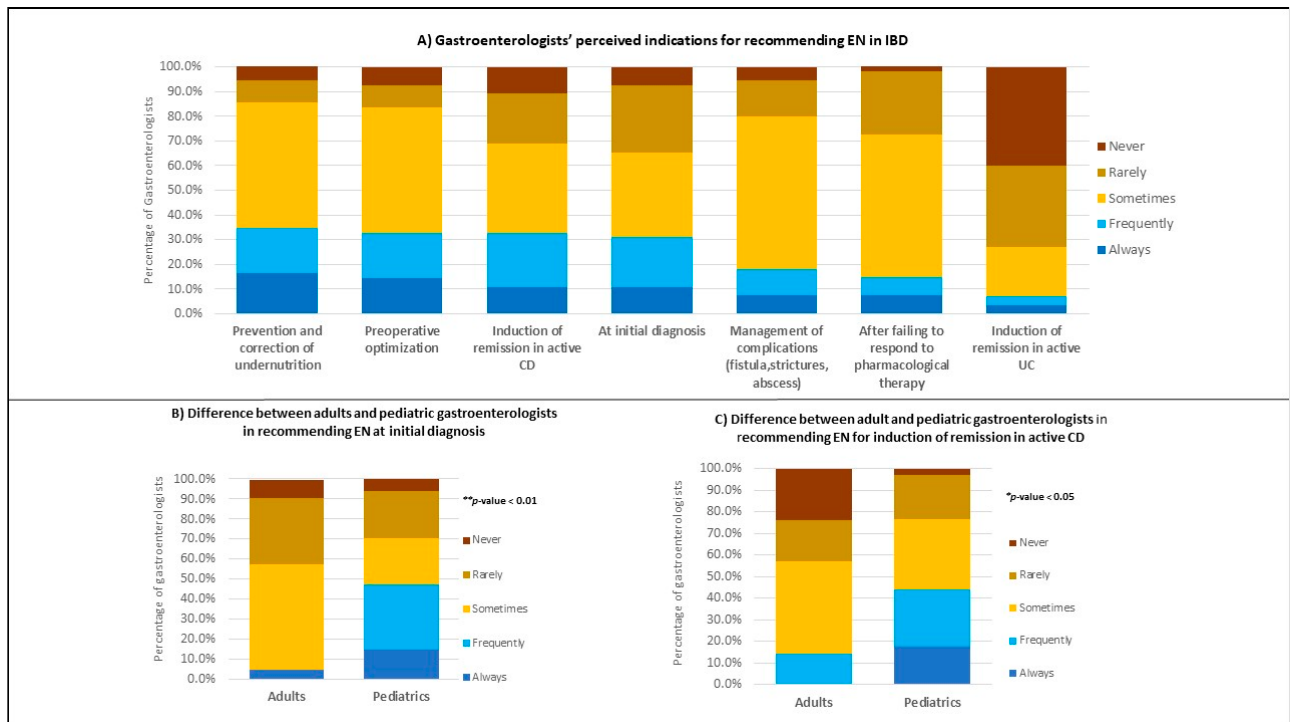
Figure 1. Indications for the use of any form of EN. ( A ) Indications reported by both adults and pediatric gastroenterologists ( n = 55). ( B ) Percentage of adult ( n = 21) versus pediatric ( n = 34) gastroenterologists who are currently recommending EN at initial diagnosis. ( C ) Percentage of adult ( n = 21) versus pediatric ( n = 34) gastroenterologists who are currently recommending EN for the induction of remission in active CD. p -values indicate the statistical difference in proportions between groups (using Chi-square and Fisher’s exact tests) .